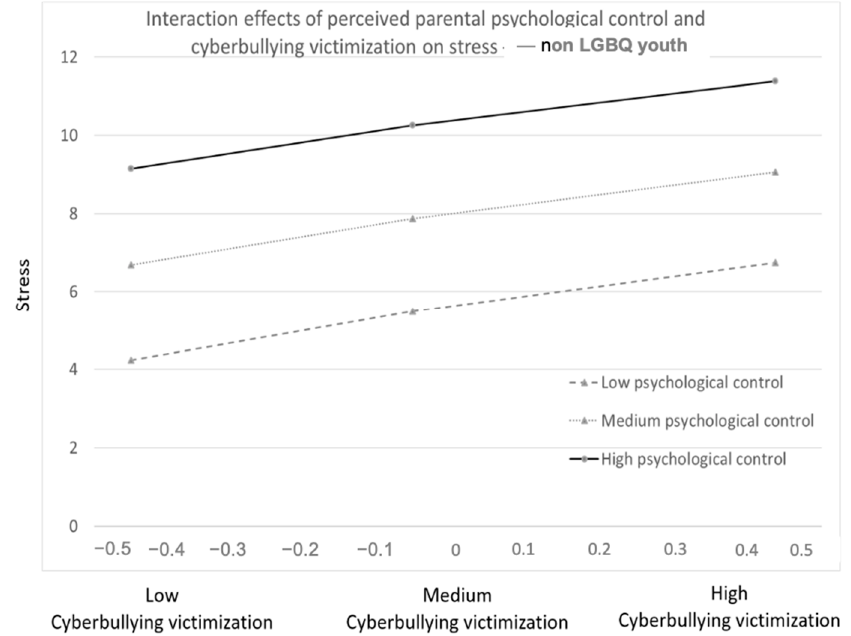
Figure A4. Interactions between autonomy support, cyberbullying victimization, and anxiety.